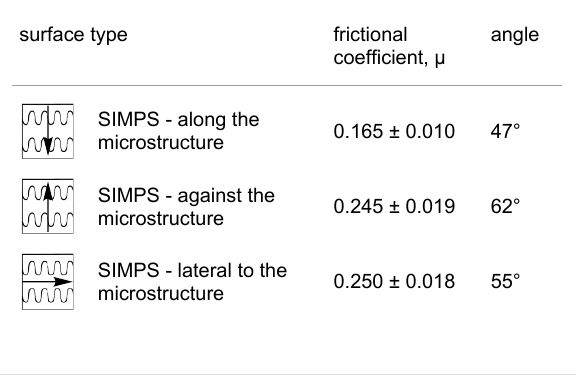
Table 2: Frictional coefficients (mean values and standard deviations) measured on SIMPS and angles of microstructure. Arrows show sliding directions of each individual